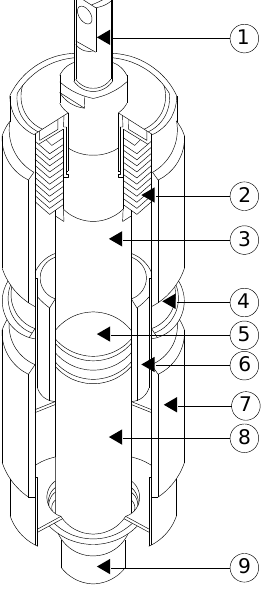
Figure 2. Cross-section of an example vacuum chamber: 1—place of connection to the movable contact, 2—spring bellows, 3—moving pole, 4—ceramic part of the housing, 5—WCu contact, 6—condensation screen, 7—glass part of housing, 8—stationary pole, 9—place of connection to stationary contact.